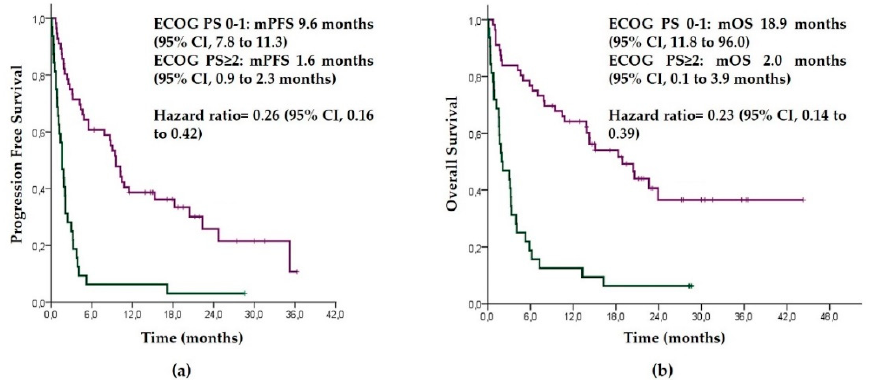
Figure 2. Comparative Kaplan–Meier curves of progression-free survival ( a ) and overall survival ( b ) according to an Eastern Cooperative Oncology Group Performance Status (ECOG PS) of 0–1 vs. ≥ 2. Line purple: ECOG PS 0-1; Line green: ECOG PS ≥ 2. mPFS (median Progression Free Survival); mOS (median Overall Survival).